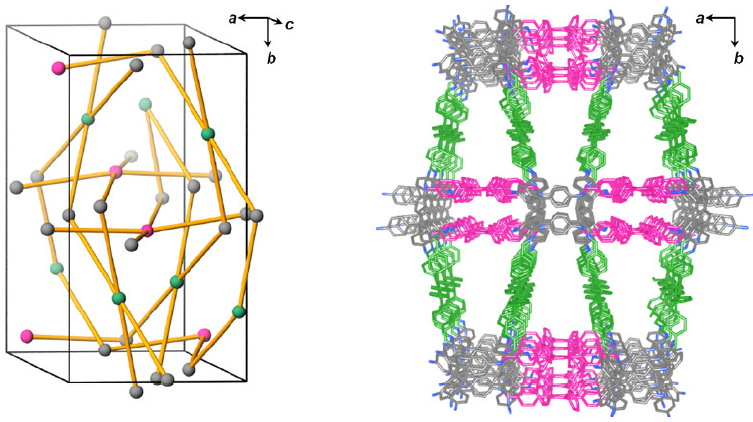
Figure 20. ljh Topology along c-axis. Reprinted (adapted) with permission from [66]. Copyright 2021 American Chemical Society.